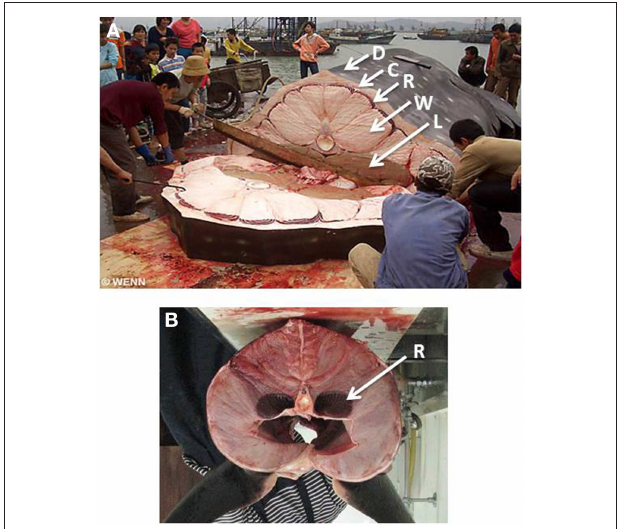
FIGURE 5 | (A) Cross-section view of a whale shark landed at a fishing dock in southern China. Note a thin external layer of denticles or placoid scales (D), a layer of connective tissue (C) a thin band of red muscle (R), and a central core of white muscle surrounding the vertebral column (W). Lobes of the liver (L) are also visible at the top of the body cavity. (B) Cross-section view of a lamnid shark, the porbeagle ( Lamna nasus ) showing red muscle (R) next to body core. Note that the photograph has been rotated so that the dorsal surface of the body is uppermost. Photograph by Matthieu Deuté (Own work), via Wikimedia